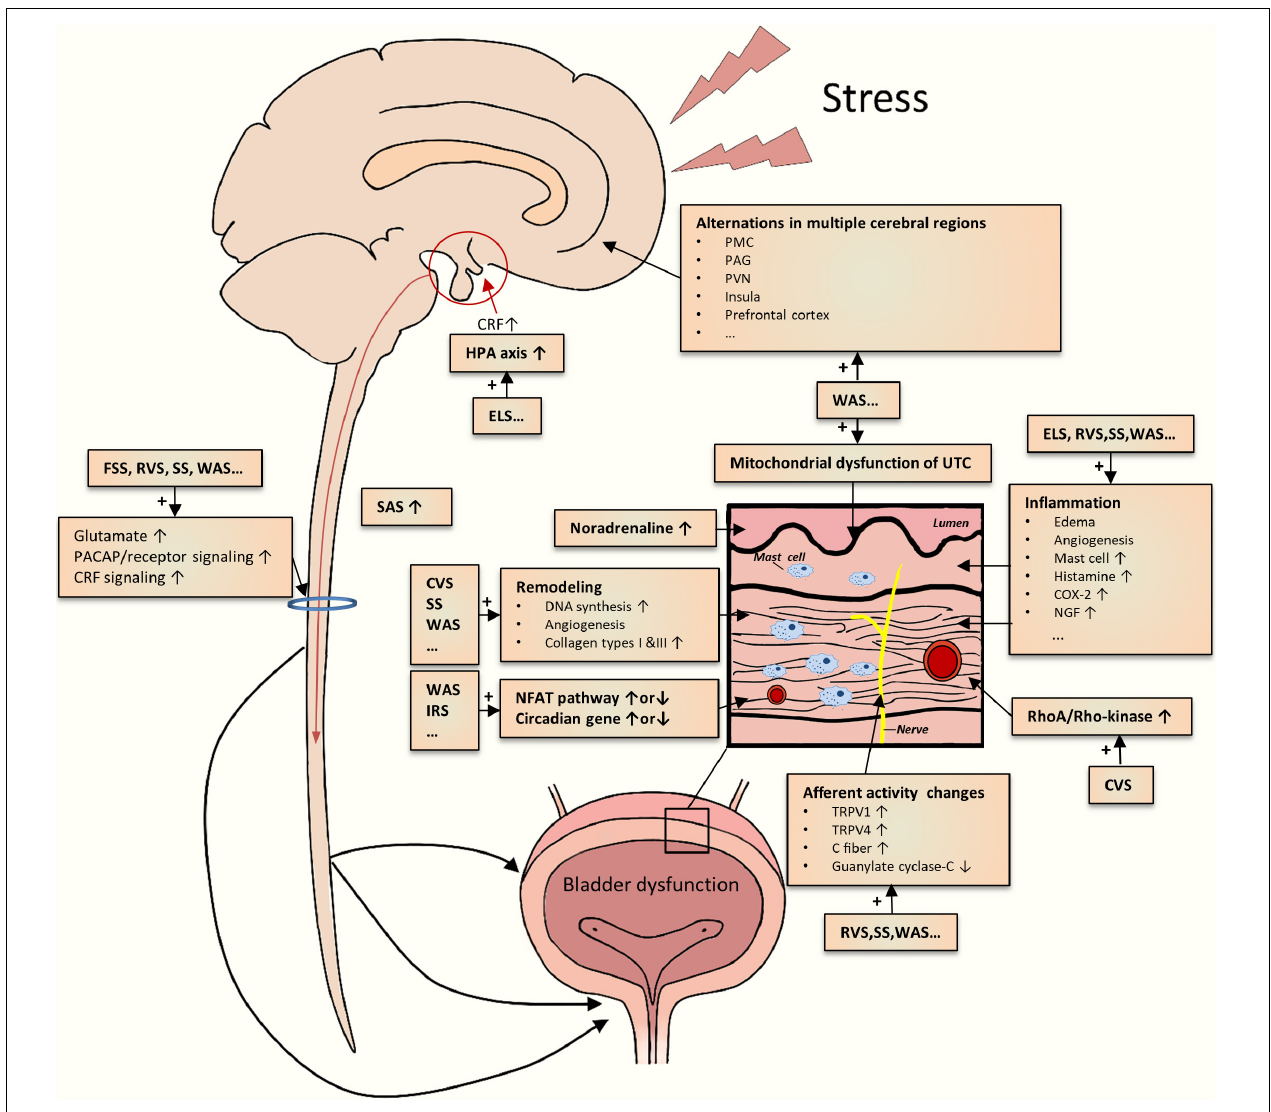
FIGURE 2 | Schematic drawing of the summarization of possible mechanisms underlying the chronic psychological stress-induced LUTD. The current studies demonstrate multiple central and peripheral alterations contributing to bladder